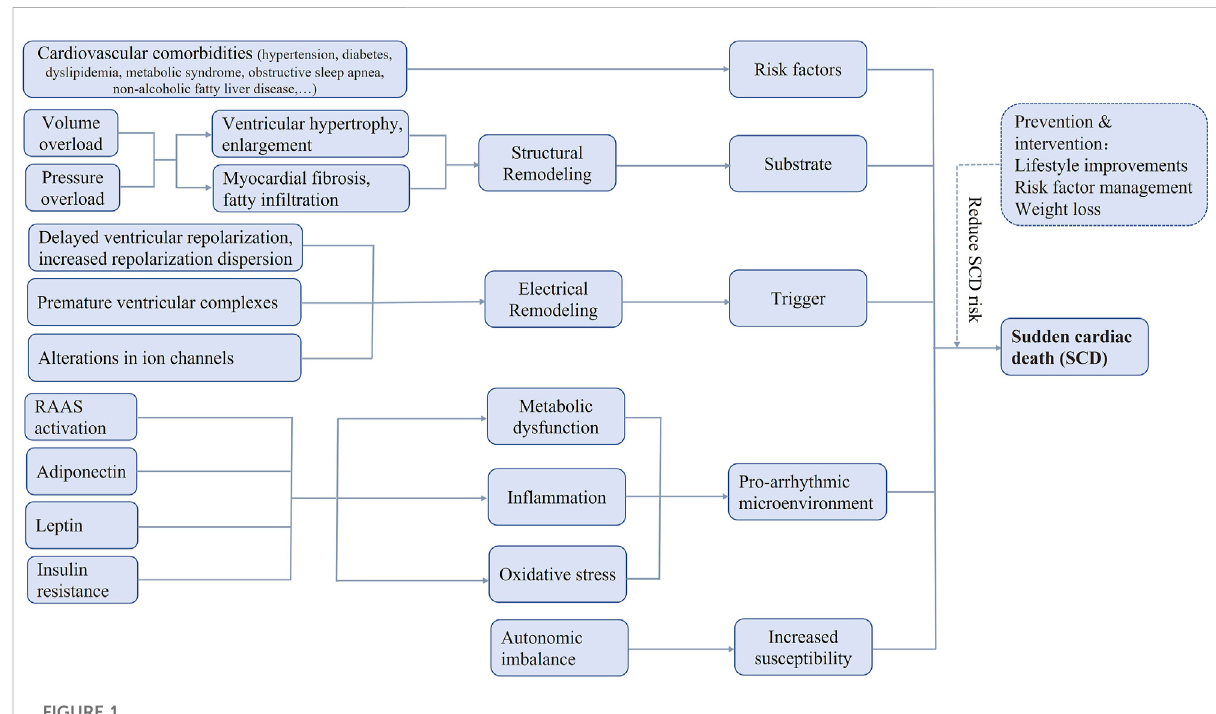
FIGURE 1 Possible pathophysiologic mechanismsof sudden cardiac death in obesity. RAAS, renin-angiotensin-aldosterone system, SCD, sudden cardiac